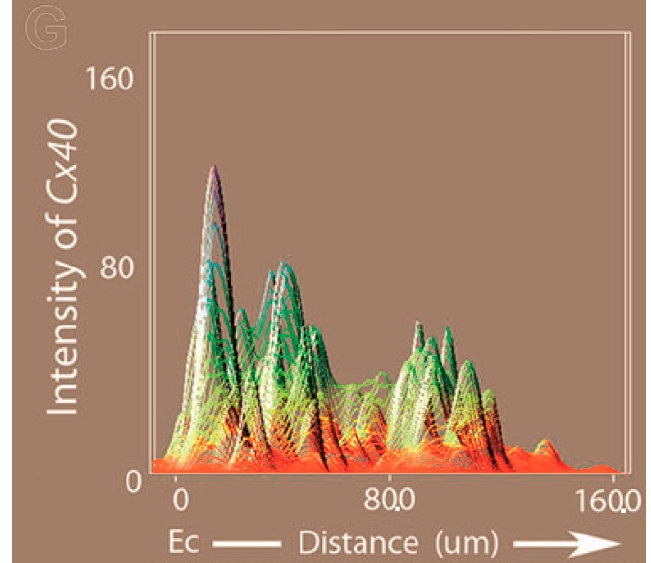
Figure 7. Proximity to the endocardium regulates Cx40 expression in atrioventricular junction (AVJ) myocytes [43]. Aggregates of AVJ cardiomyocytes were microsurgically implanted into the host superior endocardial cushions of HH stage 15–16 chicken embryos at different distances in microns from the endocardium. After 14 h of culture, the maximal intensity of Cx40 expression in the aggregates was determined by in situ hybridization and compared to their distance from the endocardium (Ec). The closer to the endocardium, the higher the intensity of Cx40 expression.